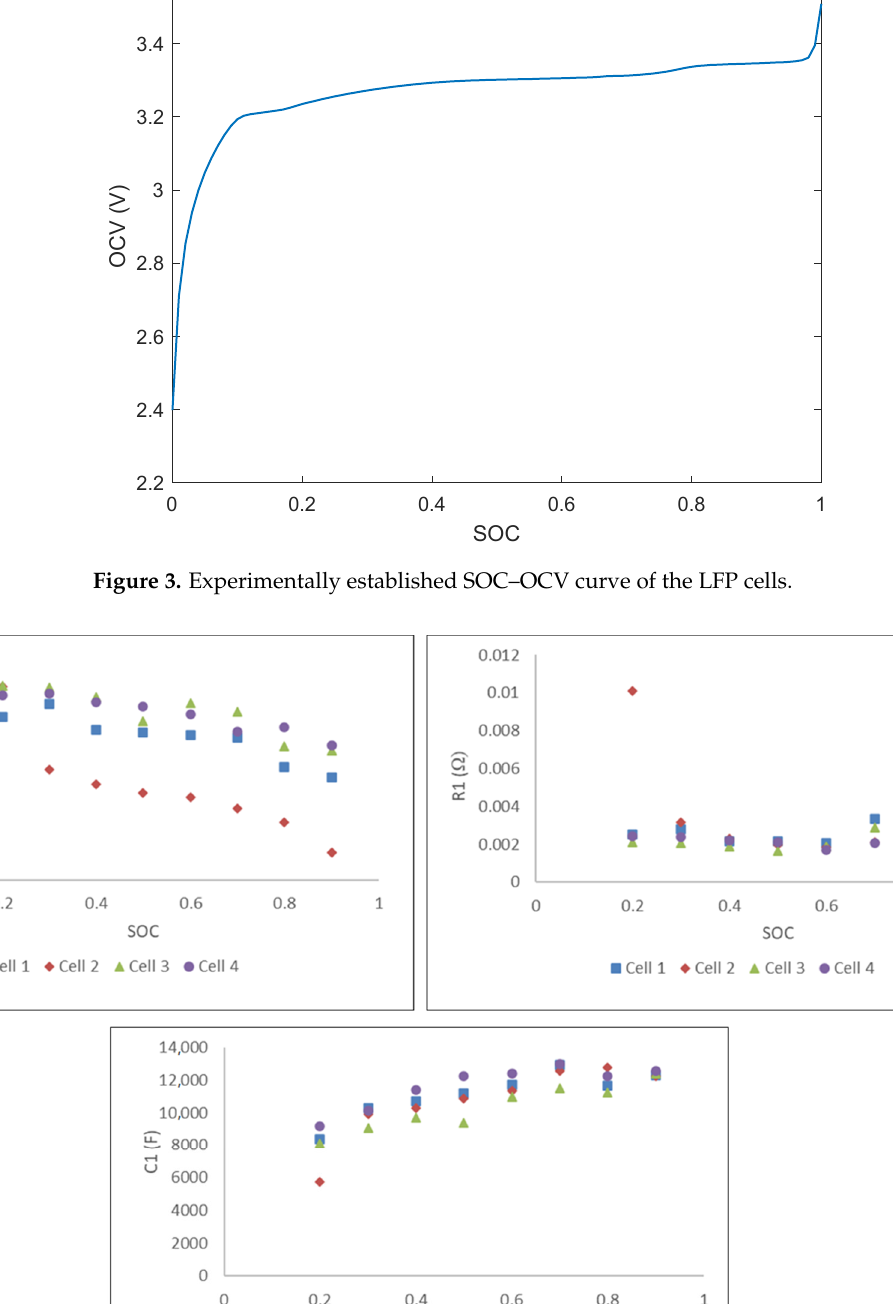
Figure 5. Cell voltage model validation plot using UDDS cycle.